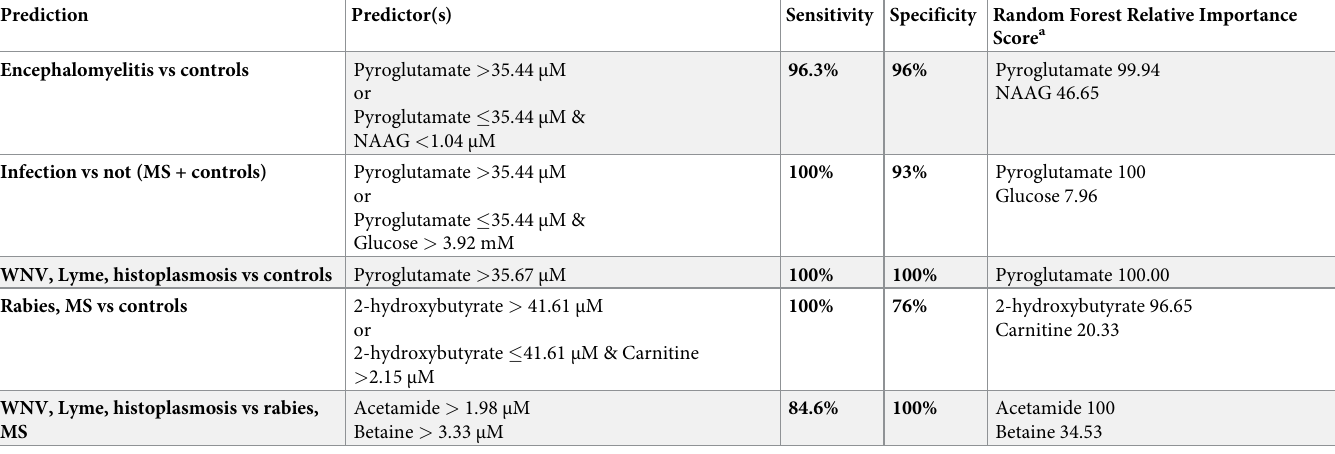
Table 5. Predictive analyses using classification and regression trees (CART) and random forest importance